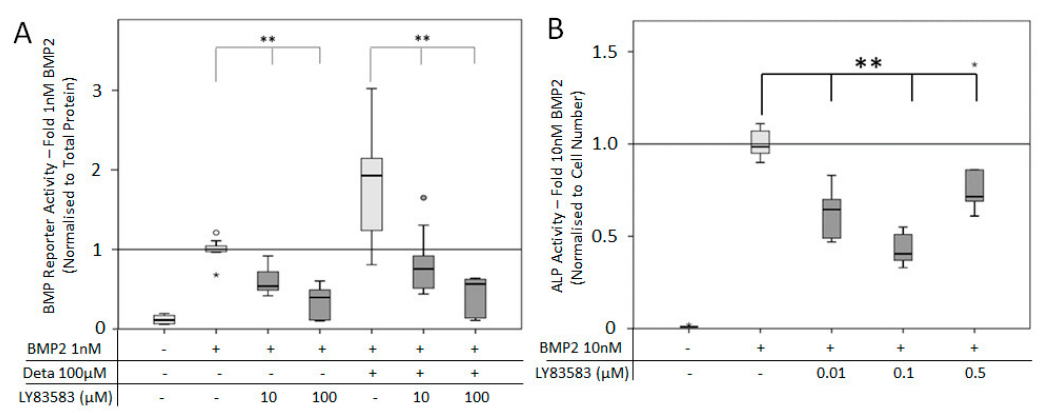
Figure 7. BMP reporter and ALP activity after inhibition of soluble guanylyl cyclase (sGC): C2C12BRELuc cell line was stimulated for 24 h in DMEM without Arginine ( A ) with 10 or 100 µ M LY83583 in the presence of 1 nM BMP2 with and without 100 µ M Deta NONOate. ( B ) ALP activity normalized to cell number after stimulation for 72 h in DMEM / Hams with 10 nM BMP2 and sGC inhibitor LY83583 (0.01 to 0.5 µ M). Statistics: Kruskal–Wallis Test followed by Mann-Whitney U test. Mann-Whitney U test significances between samples were assigned if p < 0.05 (*) or p < 0.01 (**). Abbreviation: Deta = Deta NONOate. Stars and circles are outlying values. Replications ( A ) n = 9, ( B ) n = 6.